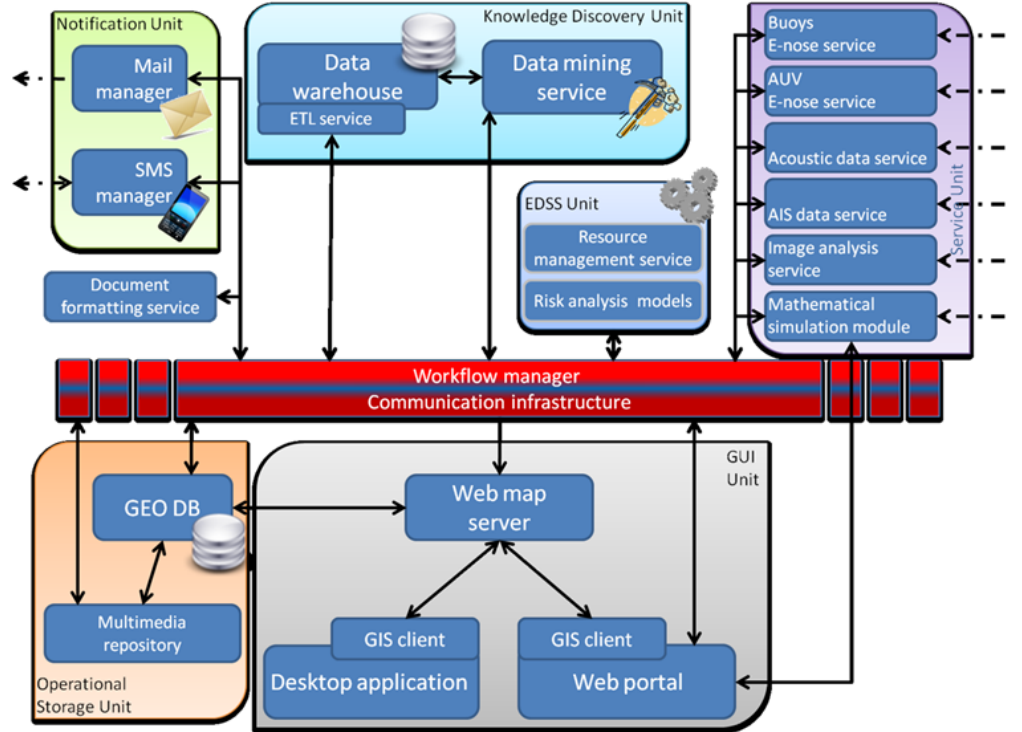
Figure 1. Architectural design of the Marine Information System with modular structure made